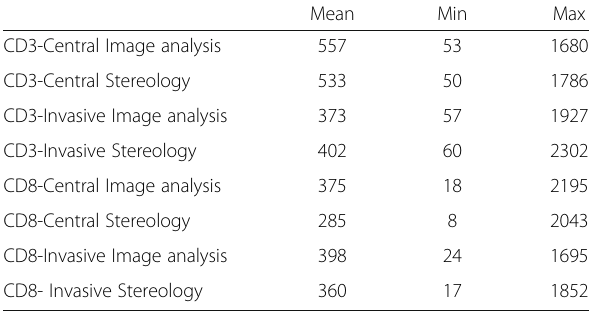
Table 1 Numerical density estimates